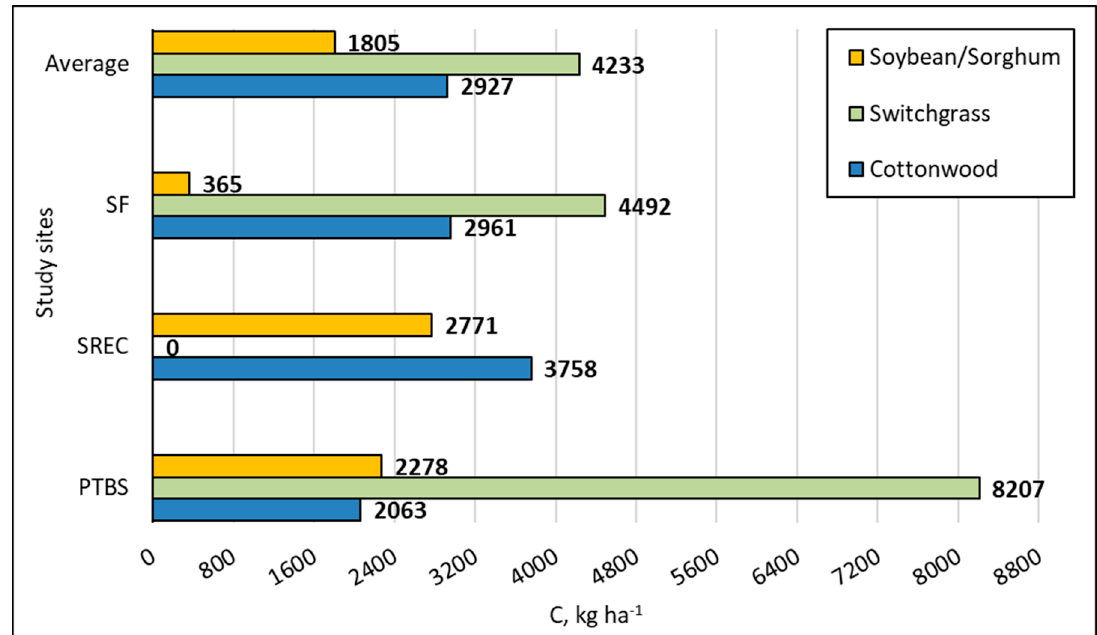
Figure 3. Total carbon (kg ha − 1 ) stored in the harvestable biomass in all three sites at the end of three years.